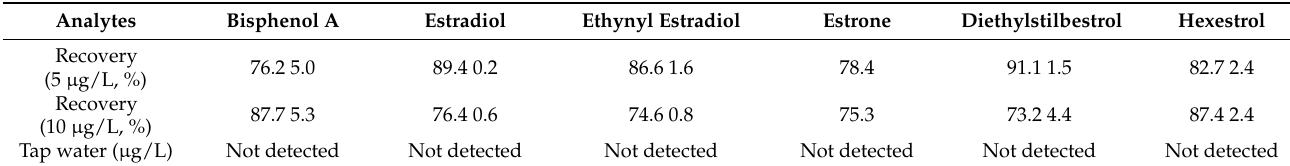
Table 2. Analysis results and recoveries (%) of six estrogens in tap